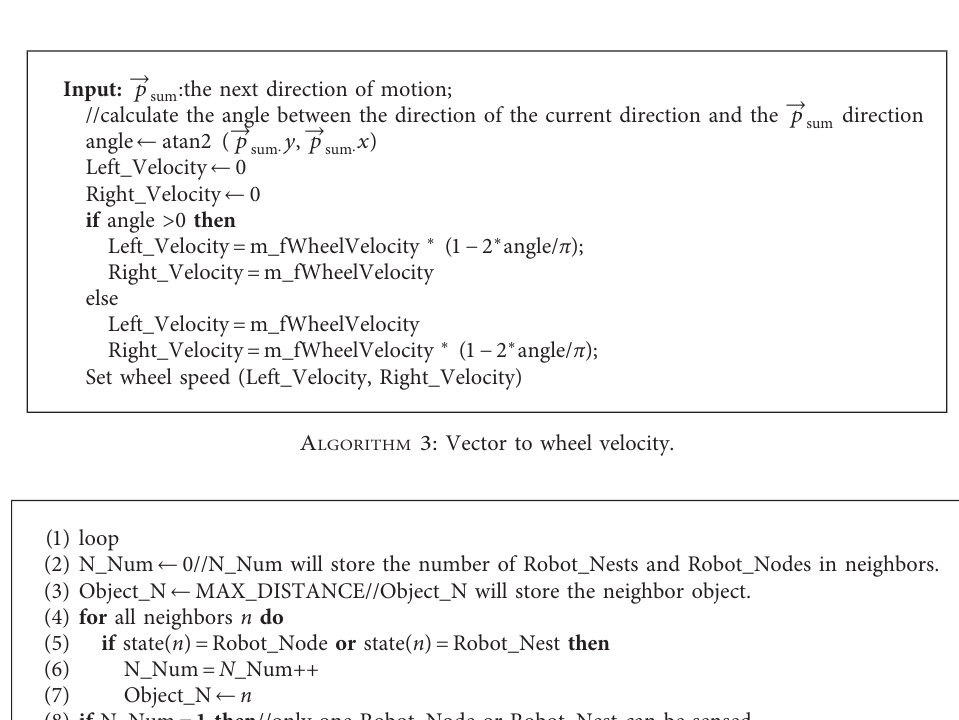
→ ( t ) is the obstacle avoidance direction. P o,i